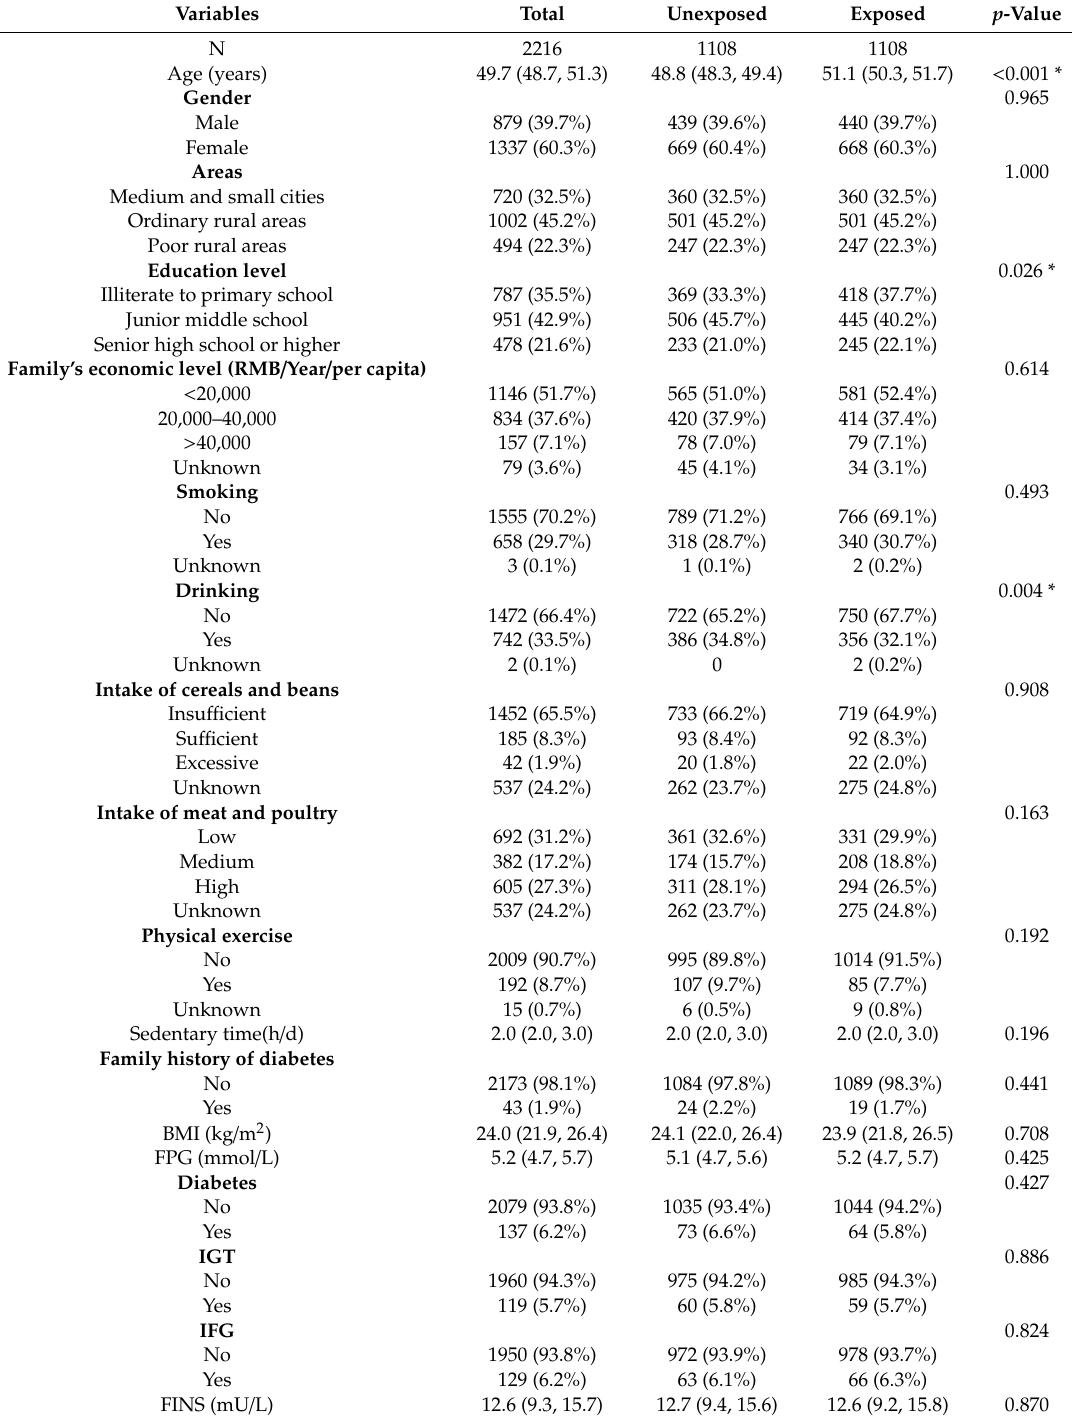
Table 1. Basic information of